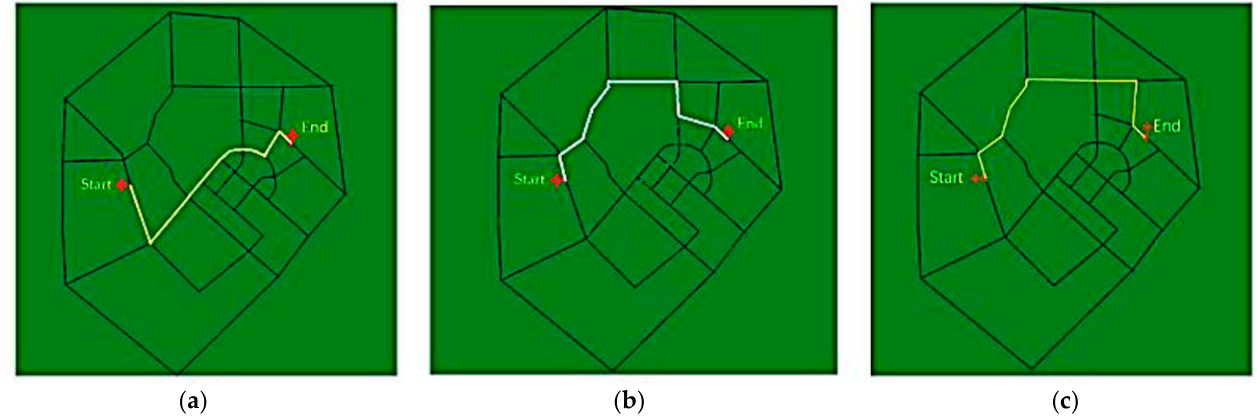
Figure 22. Optimal path obtained with different objectives: ( a ) optimal path based on shortest distance; ( b ) optimal path based on energy savings; ( c ) optimization path based on time savings.